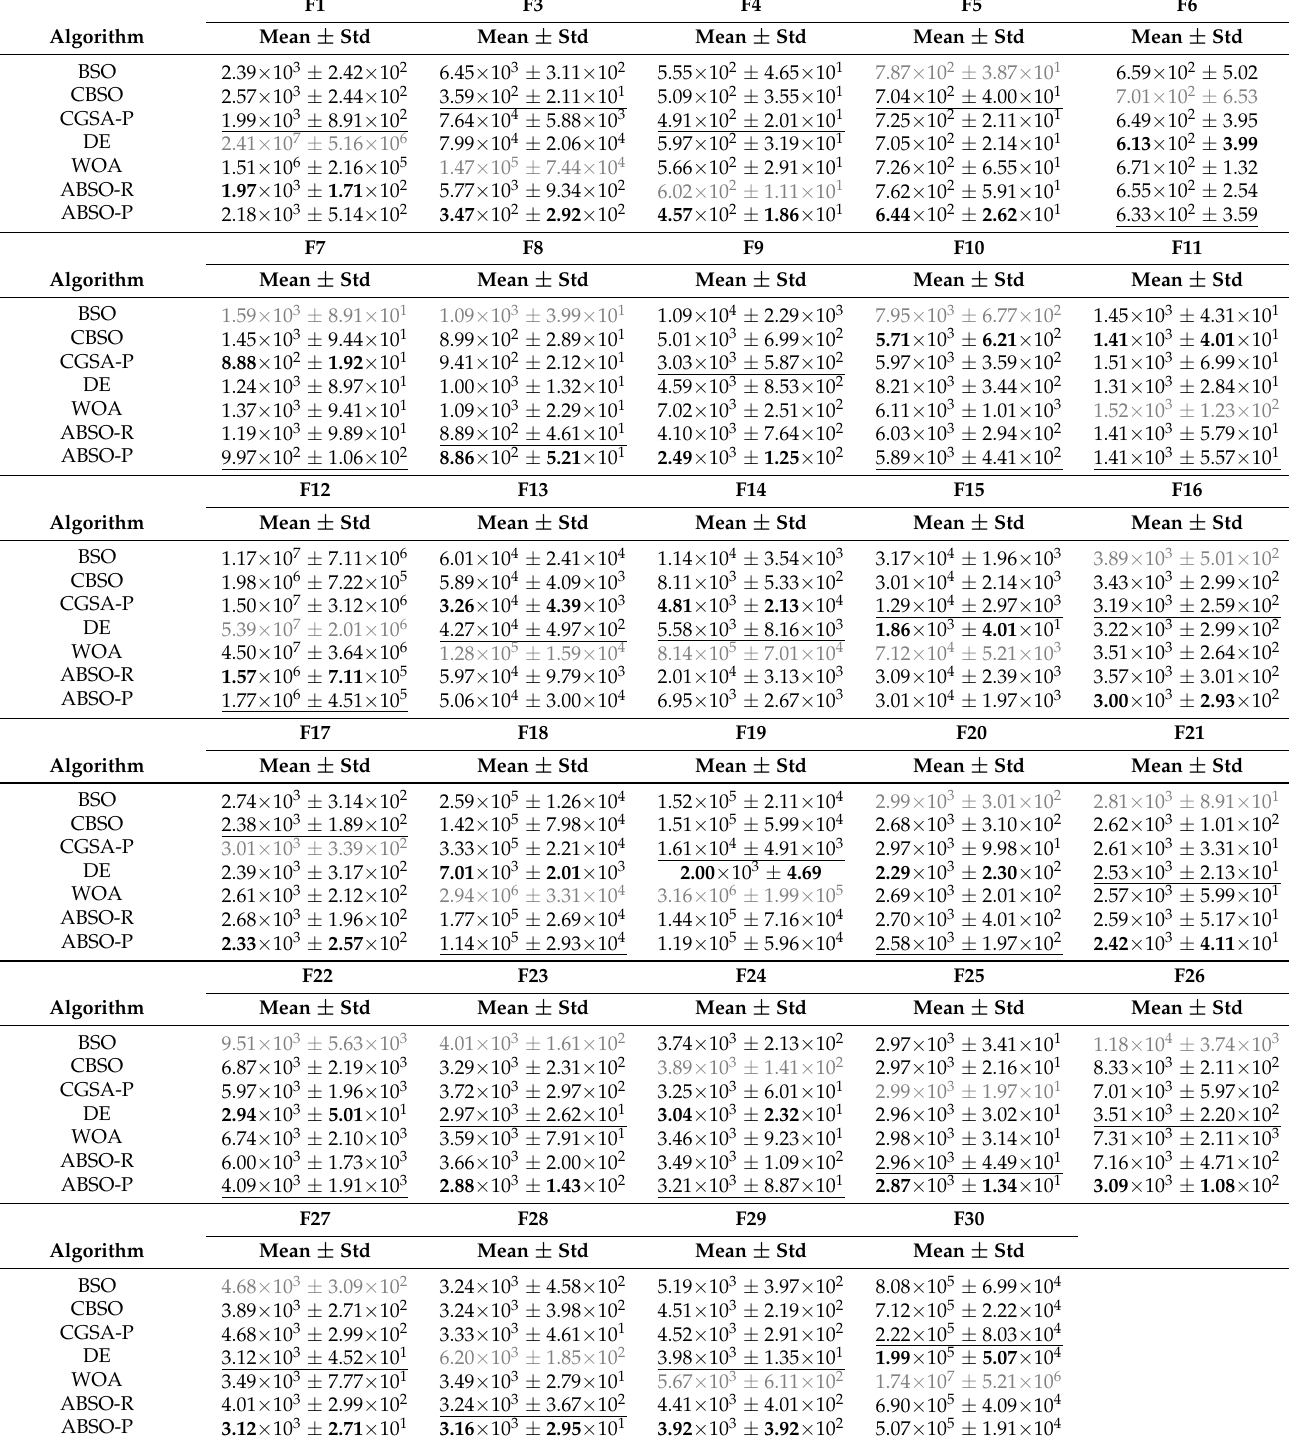
Table 1. Experimental results of CEC 17 benchmark